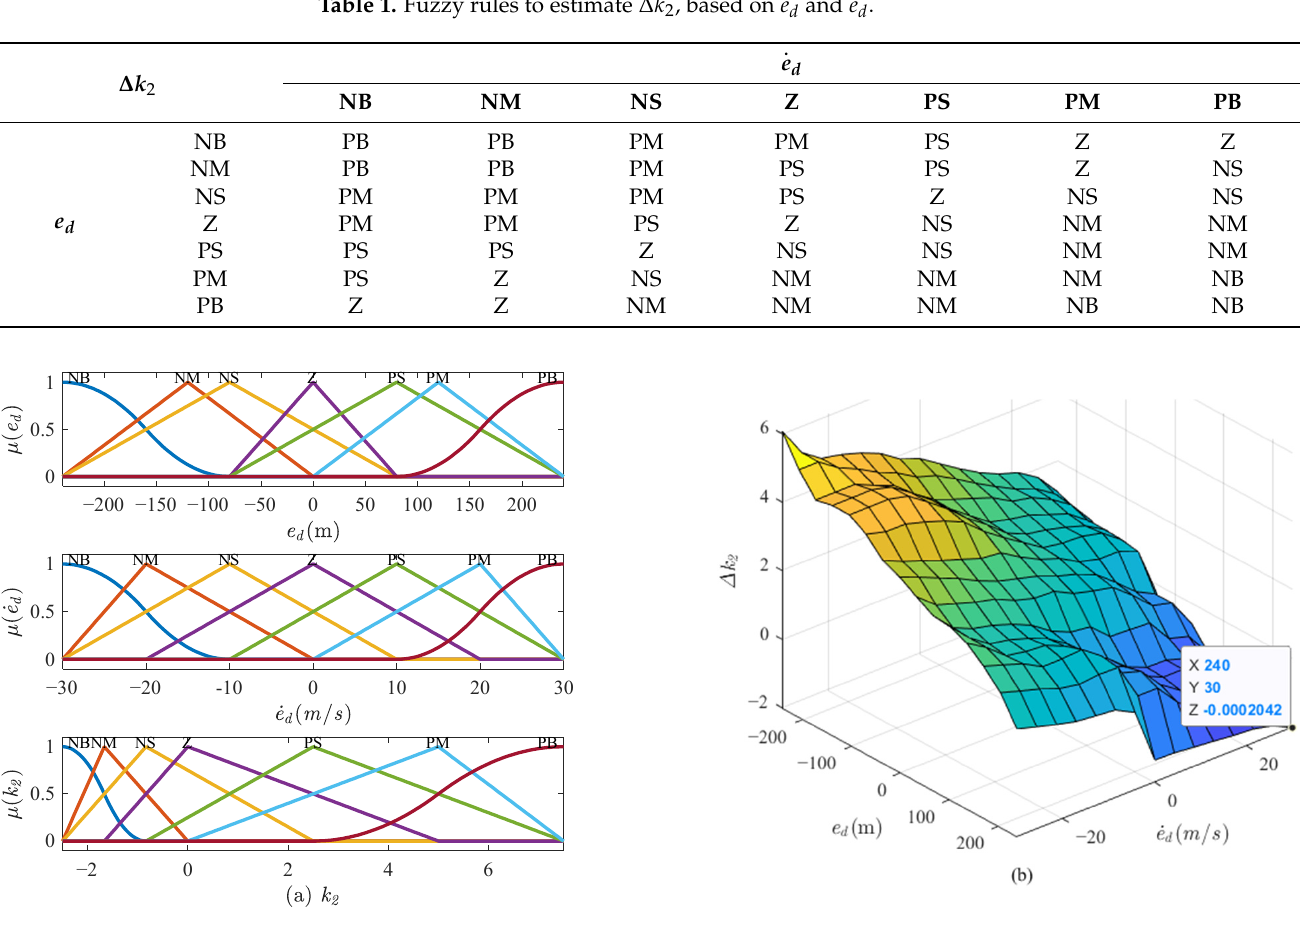
Figure 7. The properties of the fuzzy controller. ( a ) The membership functions used for the fuzzifi- cation of the inputs 𝑒 (cid:3031) and 𝑒(cid:4662) (cid:3031) , and the output ∆𝑘 (cid:2870) , respectively; ( b ) Input-output surface of the fuzzy logic controller among 𝑒 (cid:3031) , 𝑒(cid:4662) (cid:3031) , and ∆𝑘 (cid:2870) .